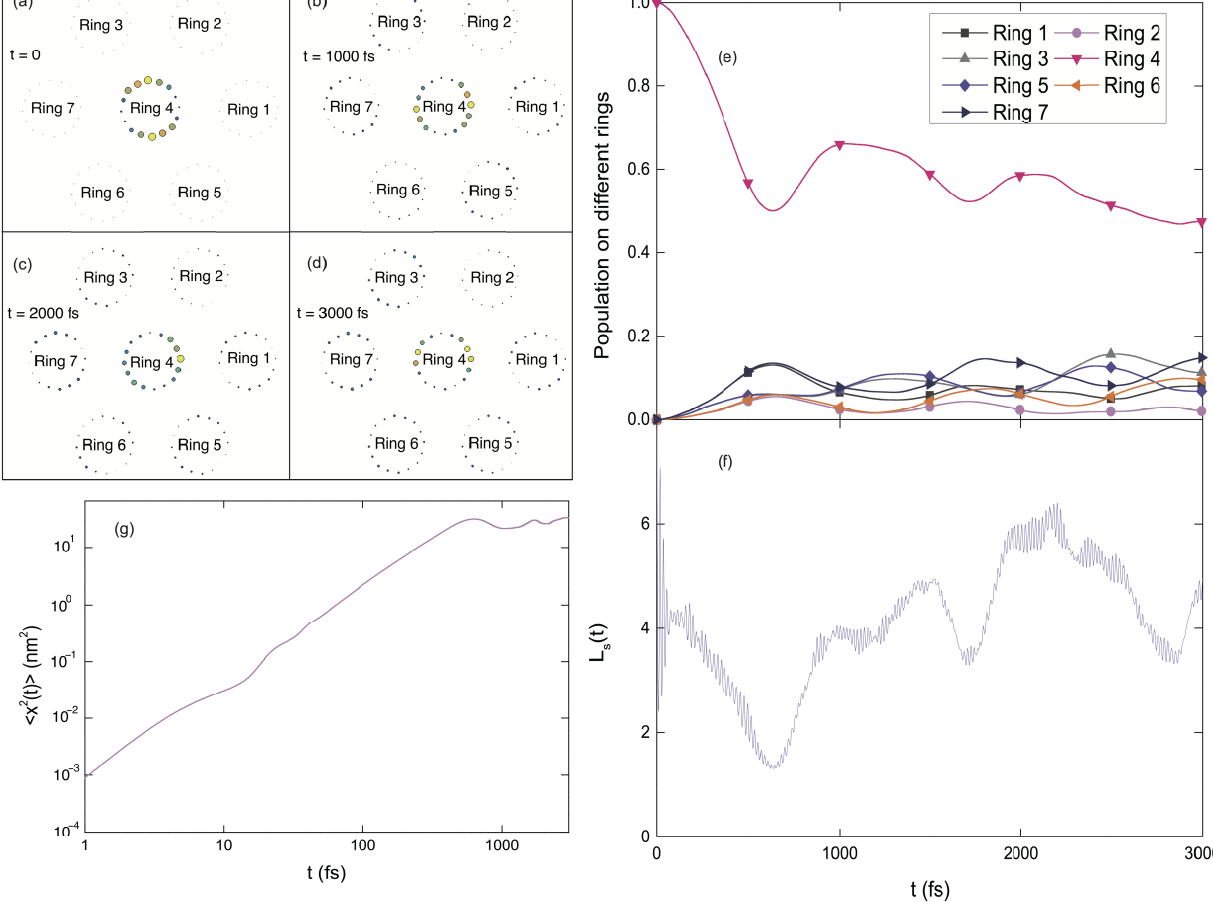
Figure 8. Exciton diffusion in a 2D nanoarray composed of 7 B850 rings. ( a – d ) Four snapshots of excitation probability distribution among all the pigments. The radii of the color bubbles represent the excitation probability on individual pigments. ( e ) Population dynamics on all the B850 rings. ( f ) Time evolution of the superradiance enhancement factor L s . ( g ) log-log plot of the mean square displacement versus